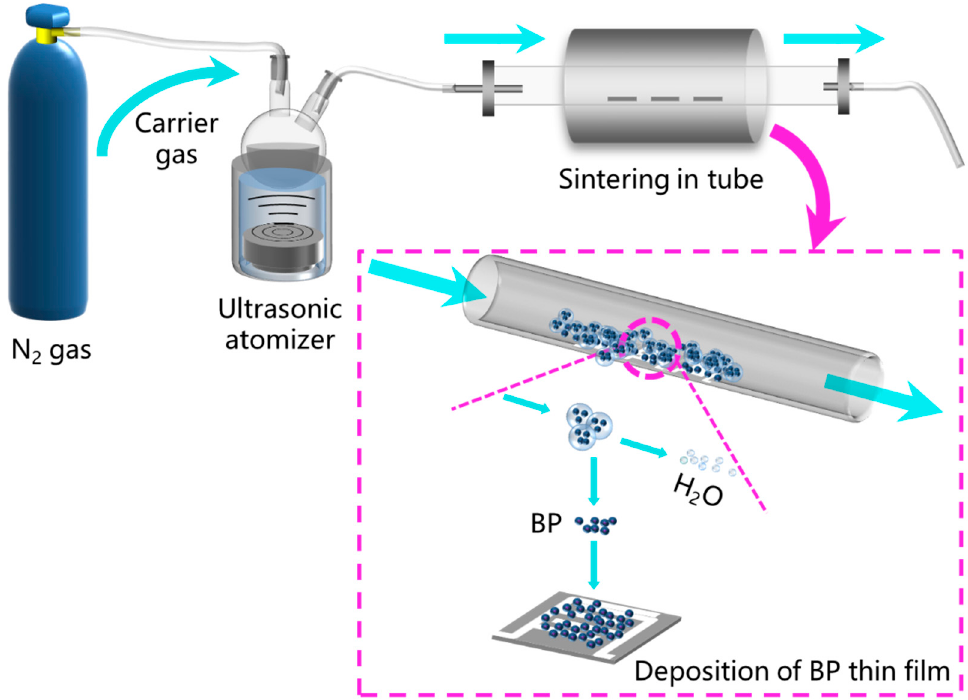
Figure 1. Aqueous preparation procedure of BP QDs from RP via the hydrothermal method.